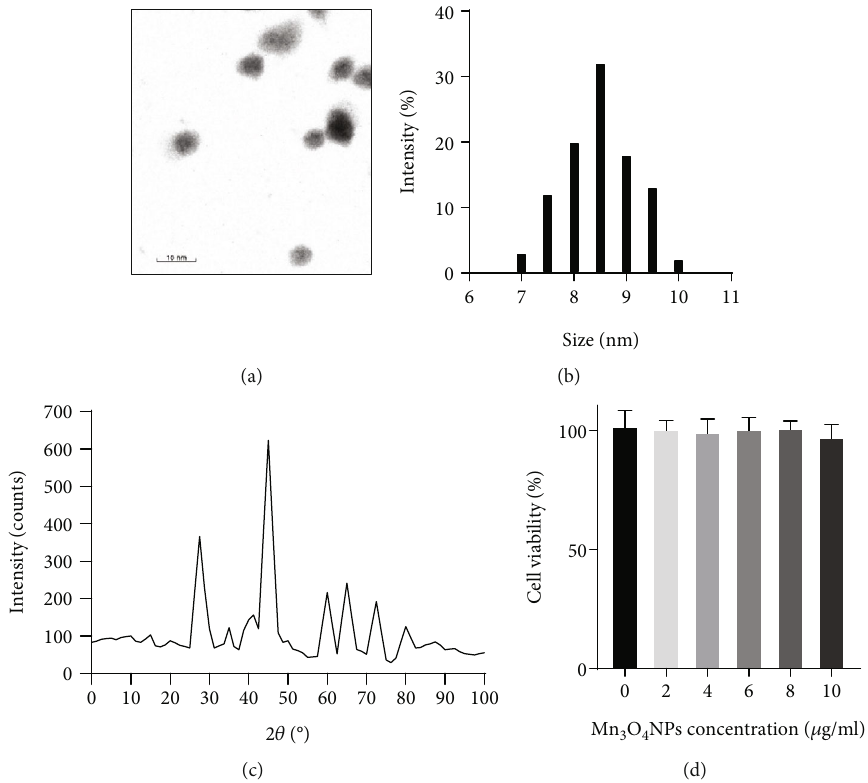
Figure 1: Identi fi cation of Mn microscope. (b) The particle size distribution range of Mn Mn O NPs detected by X-ray di ff raction. (d) Detection of the cytotoxicity of Mn 3 4